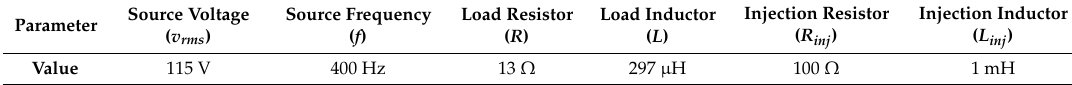
Table 1. Simulation parameters for three-phase resistor/inductor ( RL ) network.